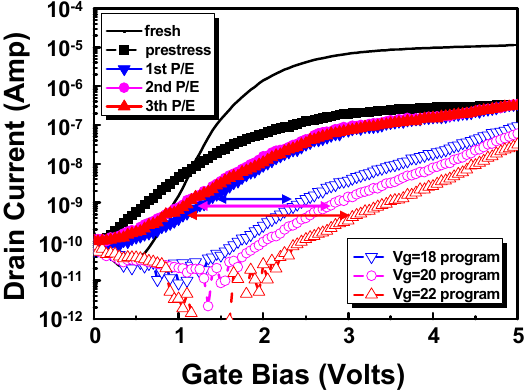
-V characteristics of the bottom-gate poly-Si nanowire FETs with ONO-buried Figure 7. I d g oxide at different operation modes. With the completion of the initial pre-stress, V adjusted after adequate